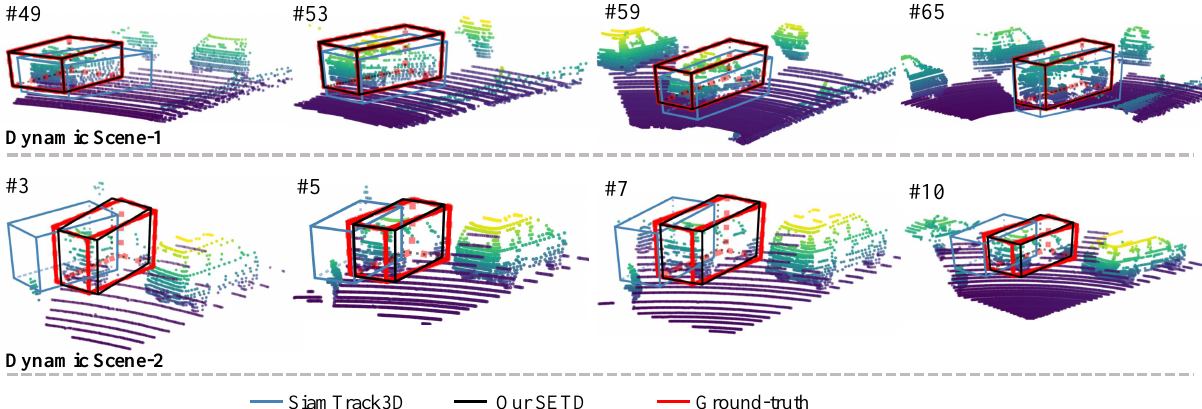
Figure 5. Visual results on density change. We exhibit some key frames of two different objects. Compared with SiamTrack3D ( blue ), our SETD ( black ) has a larger overlap with the ground truth ( red ). The number after # refers to the frame ID.